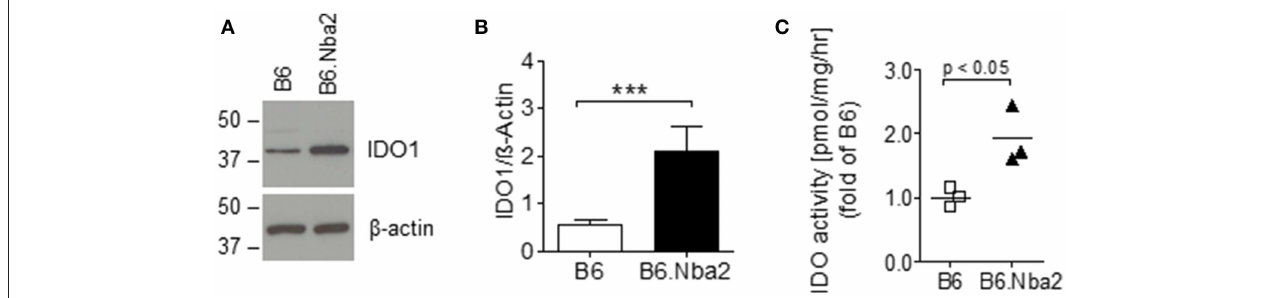
FIGURE 1 | IDO1 is elevated in disease-prone B6.Nba2 mice. Western blot analysis of splenic IDO1 levels in unmanipulated, 16 week old female B6 and B6.Nba2 mice. (A) One sample representative is shown for B6 and B6.Nba2. (B) Quantification of IDO1 western blot analyses [B6: n = 6; B6.Nba2: n = 3]. Each bar shows